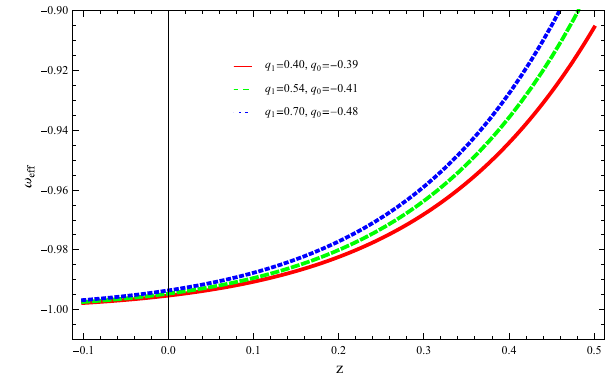
Fig. 2 Plot of v 2 s versus z at Hubble horizon with Bekenstein entropy